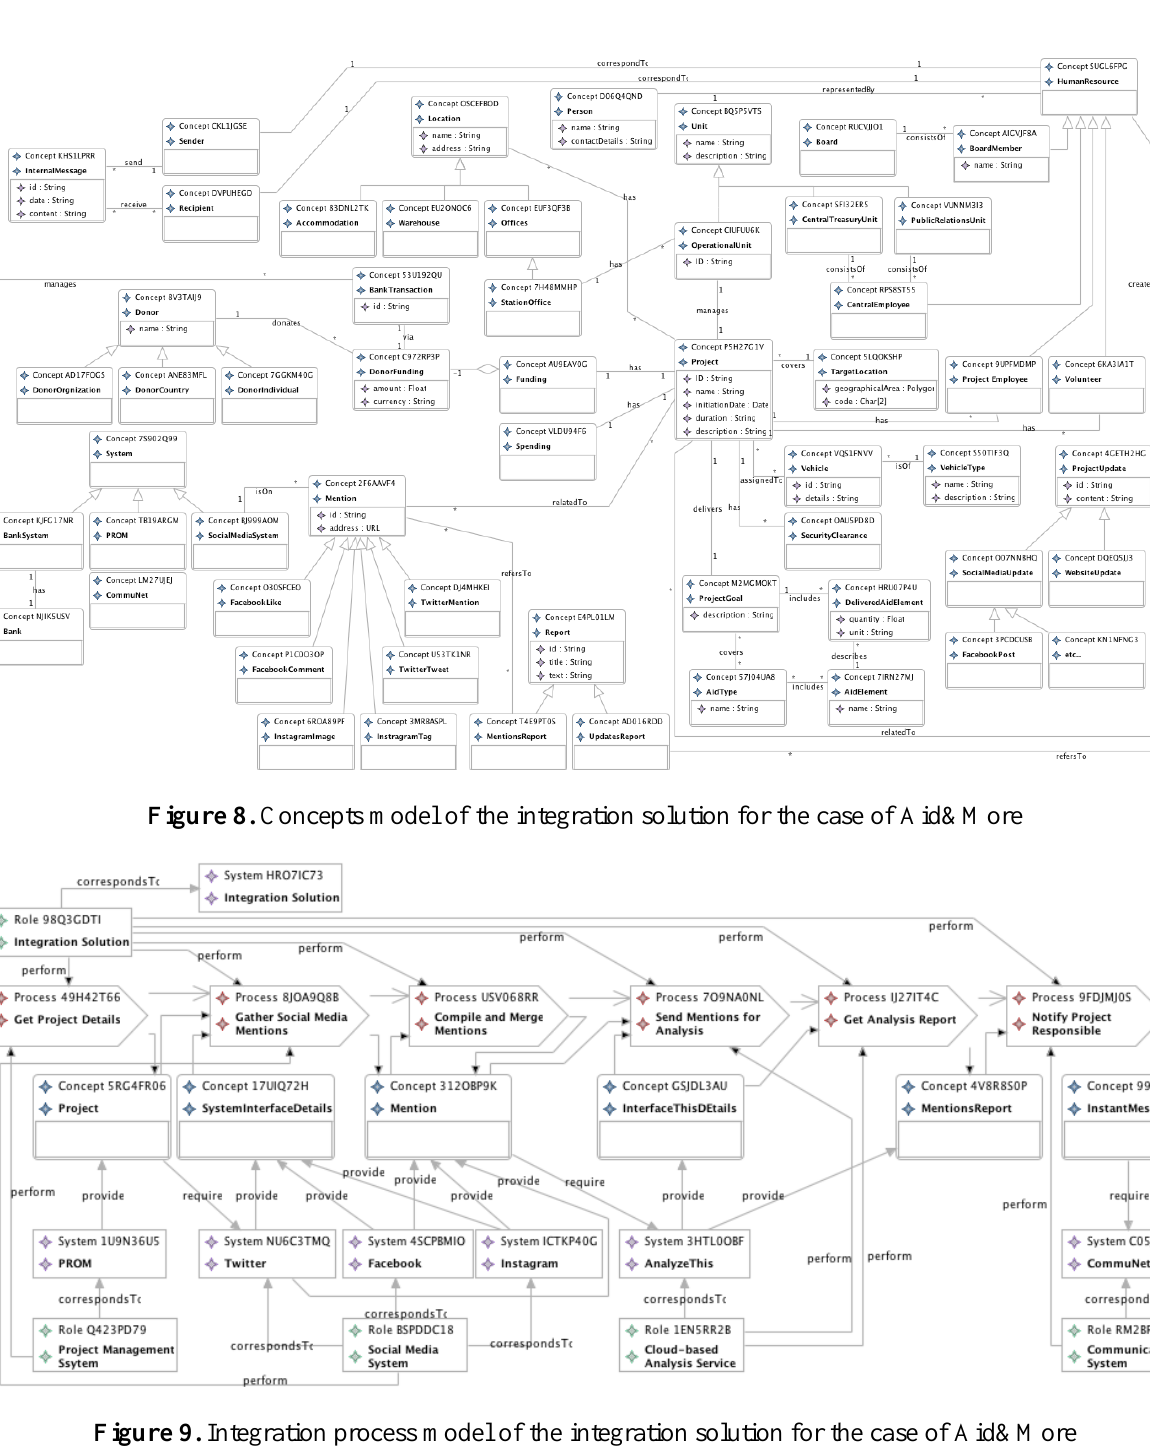
Figure 9. Integration process model of the integration solution for the case of